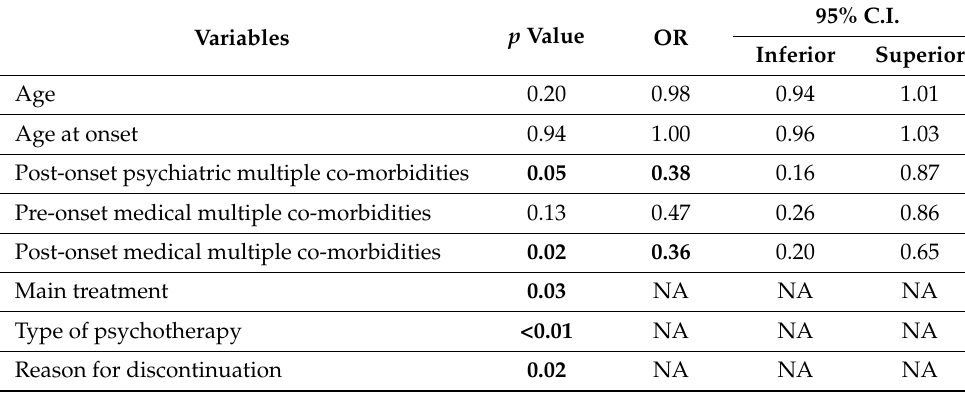
Table 2. Association between significant variables and GAD/PD diagnosis: logistic regression model